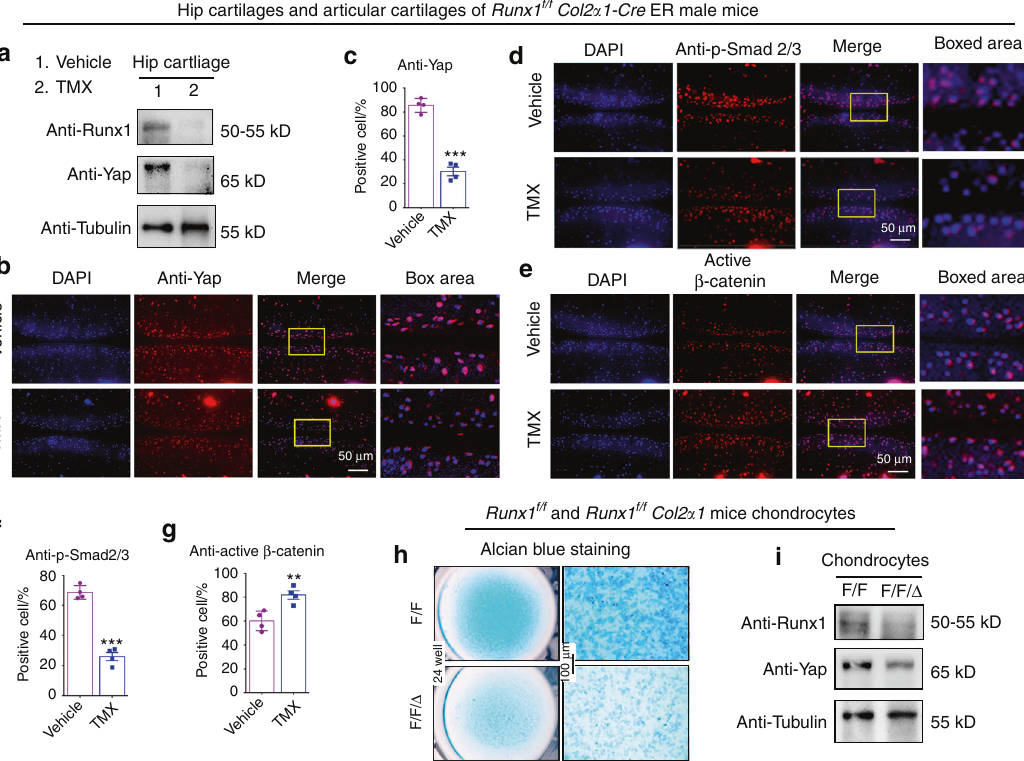
Fig. 5 Loss of Runx1 in cartilage led to a decrease in Yap and p-Smad2/3 and an increase in active β -catenin. a Western blot of hip cartilage from 2-month-old male Runx1 f/f Col2 α 1-Cre ER mice induced by vehicle (control) or tamoxifen (TMX). b IF staining with anti-Yap in 3-month-old male Runx1 f/f Col2 α 1-Cre ER mice. Bar: 50 μ m. c Quanti fi cation of ( b ). d , e IF staining with anti-p-Smad2/3 and anti-active β -catenin. Bar: 50 μ m. f , g Quanti fi cation of ( d and e ). h Alcian blue staining of primary chondrocytes cultured from newborn Runx1 f/f (F/F) and Runx1 f/f Col2 α 1-Cre (F/ F/ Δ ) mice in chondrogenic medium for 14 days. Bar: 100 μ m. i Western blot. Primary chondrocytes were induced 14 days from newborn mice. The results are presented as the mean ± SD, n = 4, ** P < 0.01, *** P < (Fig. 5h, i). The data indicated that Runx1 may be involved in cartilage regeneration by regulating YAP levels. Runx1 overexpression in chondrocytes promoted YAP protein levels in vitro, and local Runx1 overexpression by AAV protected against OA in an ACLT mouse model in vivo To further explore the function and mechanism of Runx1 overexpression in cartilage, we used pMXs-Runx1 and AAV- Runx1 vectors to enhance Runx1 expression in vitro and